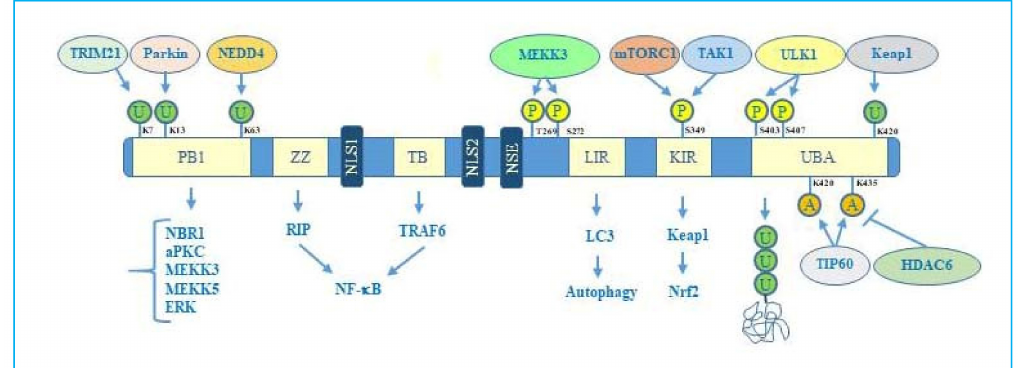
Figure 1. p62 structure, functional domains, post-translational modifications, and interactors. In particular, the figure shows Phox / Bem1p (PB1) domain, which is important for p62 oligomerization, with indicated ubiquitination sites, relative ubiquitinating enzymes (Trim21, parkin, NEDD4) and interactors (NBR1, atypical protein kinase C (aPKC), MEKK3, MEKK5, ERK); Zinc finger ZZ and TRAF bindingTB domains necessary for interaction with receptor interacting protein (RIP) and TRAF6, respectively, to activate NF- κ B signalling; nuclear localization sequences (NLS1 and NLS2), and nuclear export sequence (NES) which account for nuclear-cytoplasmic shuttling of p62; LYR and Keap1-interacting region (KIR) domains that interact with LC3 and Keap1 respectively to promote selective autophagy and nuclear factor (erythroid-derived 2)-like 2 (Nrf2)-mediated signalling. Ubiquitin associated (UBA) domain is fundamental for recognition of poly-ubiquitinated cargo during selective autophagy. Post-translational modification sites including phosphorylation, acetylation, and ubiquitination together with the respective regulative enzymes (MEKK3, mTORC1, TAK1, Keap1, Tip60, HDAC6) are also